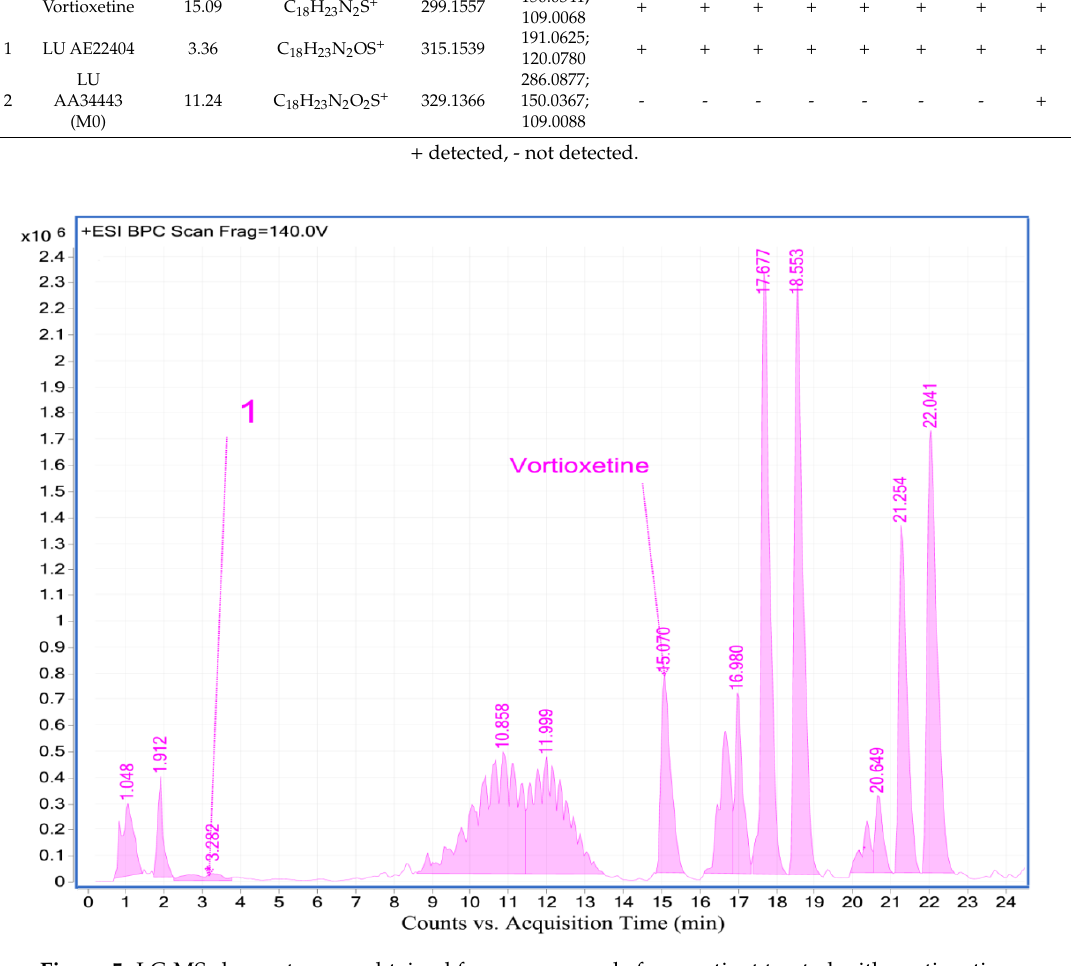
Figure 5. LC-MS chromatogram obtained for serum sample from patient treated with vortioxetine.